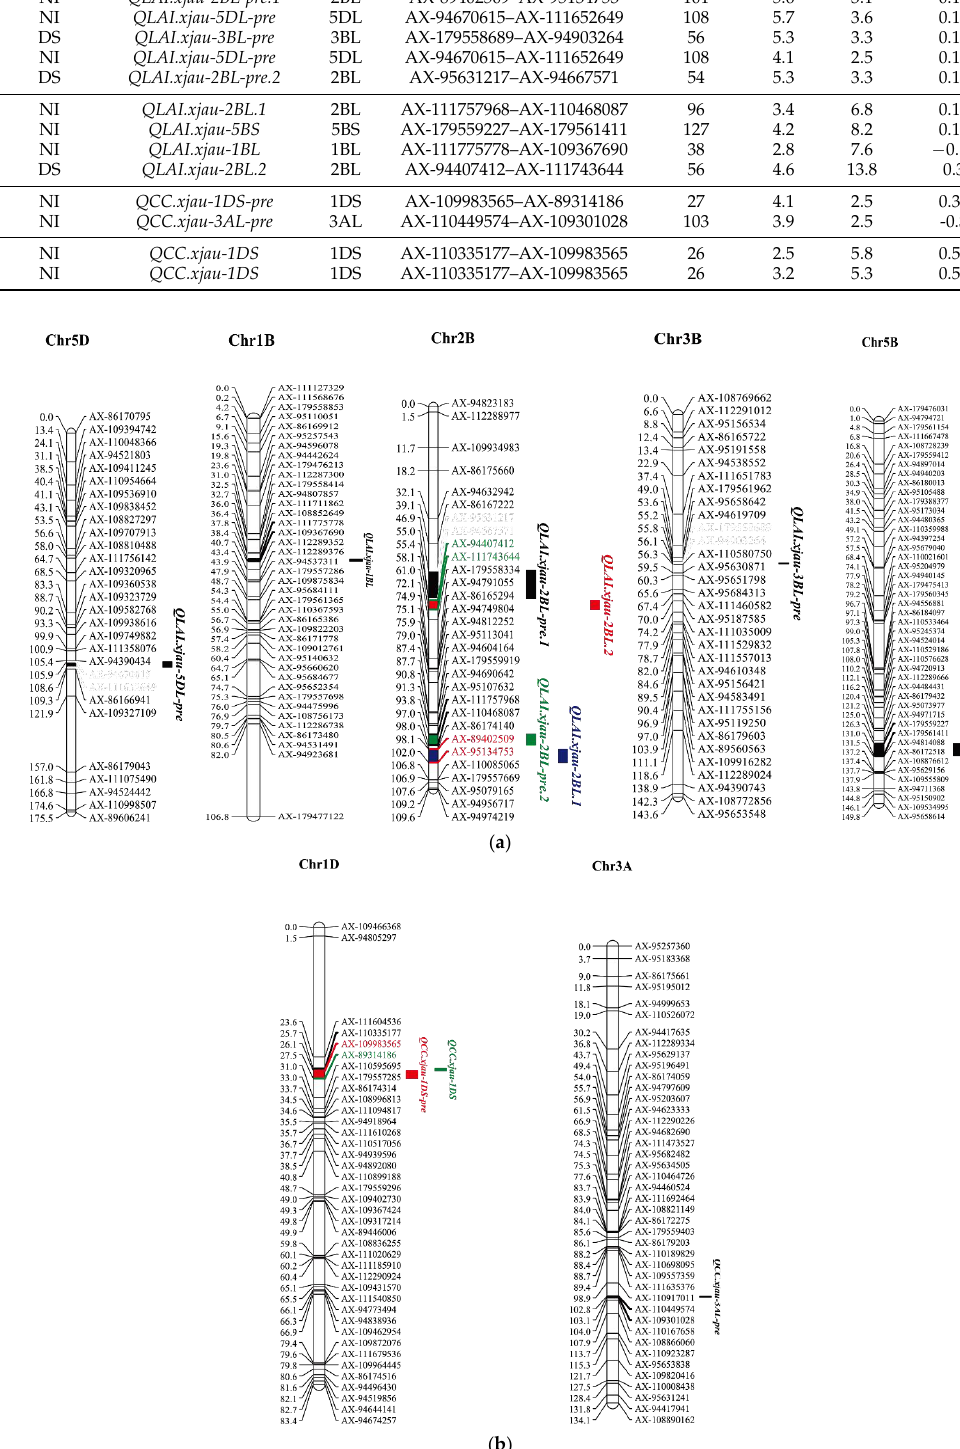
Figure 5. ( a ) QTL mapping of LAI; ( b ) QTL mapping of CC. The right side of each chromosome is the molecular marker, and the left side is the genetic position of the molecular marker. 3.6. Candidate Gene Mining and Comparative Analysis of Predicted and Measured Values